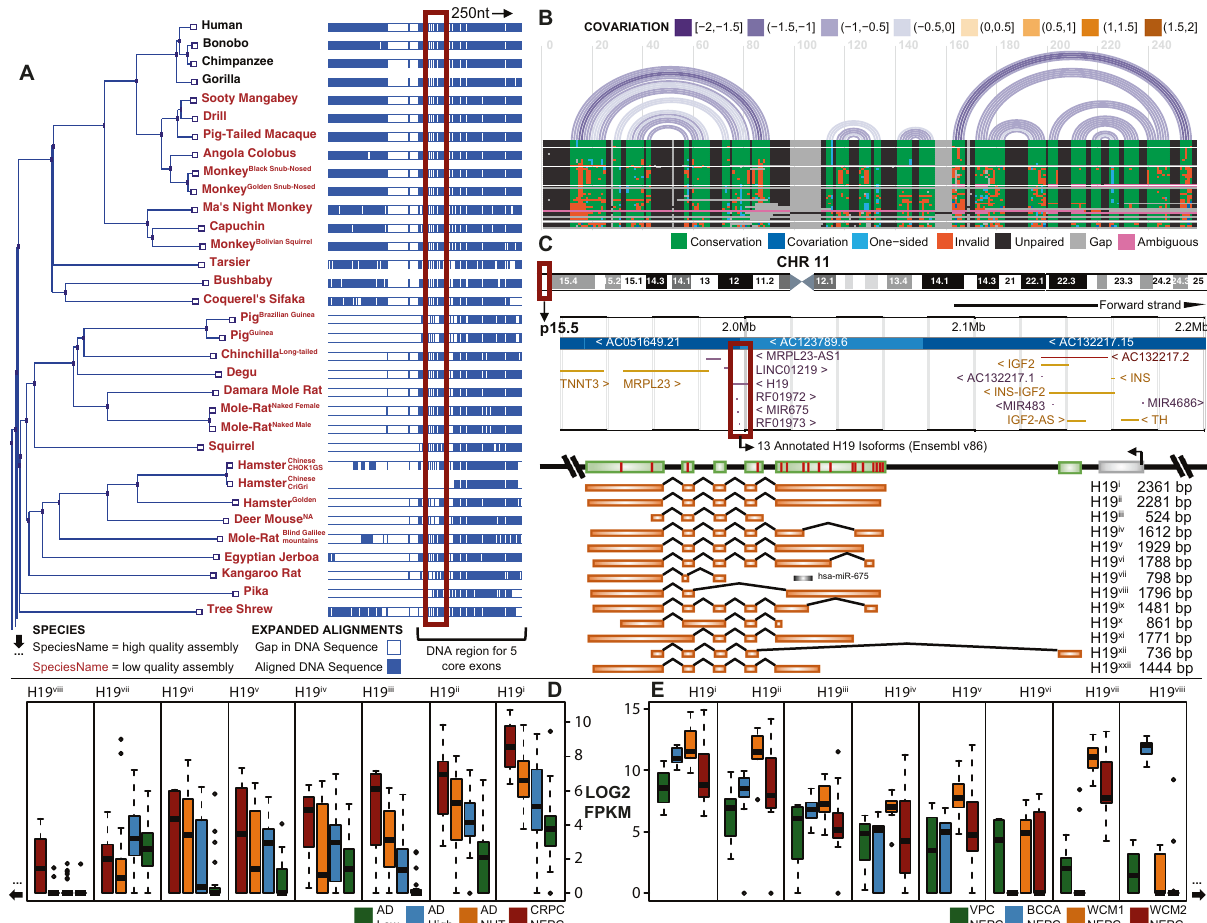
Fig. 2 H19 Isoform identi fi cation and conservation. A Phylogenetic tree (left side) and multiple sequence alignment (right side) for all available H19 DNA sequences of eutherian species ( n = 47) in Ensembl v93. Regions of the MSA that represent gap sequence(s) (white — unaligned sequences) are mostly intronic and regions representing complementary sequence(s) (blue — aligned sequences) are mostly exonic. The fi ve core exons of H19 (right side of MSA) are predominately conserved across all test species, suggesting shared functional importance. Due to limited fi gure space, only 33 of 47 species of this phylogenetic tree have been shown here. The complete ( n = 47) phylogenetic tree is shown in Supplementary Fig. 5. The highlighted box (red) spans a ~250 nt region where we narrow/zoom into for a B detailed MSA (horizontal bars) and integrate RNA secondary structure (purple arcs). Each bar/row represents a test species and is in the order shown from the phylogenetic tree in ( A and Supplementary Fig. 5). Each arc represents a nucleotide base pairing and binding event. Most of this region is highly conserved (green), yet despite areas with sequence differences (blue, light blue, orange, or gray), these changes do not affect H19 ’ s secondary structure, which is stable and contains little covariation (denoted by arc colour). C Schematic of human chromosome 11 (top), H19 ’ s locus and neighboring genes (middle), and Ensembls ’ 13 annotated isoforms and exon-exon structures (bottom) — H19i through H19xxii. The order and number of isoforms were assigned based on expression ranking observed in panels ( D ) and ( E ). Each isoform (orange) is transcribed from the DNA region (green) through alternative splicing events (red bars). Each red box in this panel highlights the region expanded below them. D Expression of each isoform in various clinical subgroups of the VPC cohort ( n = 75). H19i (rightmost boxplot) displays the highest expression across all subgroups, H19ii second, and so forth going left. The order of isoforms in this plot was determined by decreasing mean (m) expression across subgroups. E Expression of each H19 isoform in order (left to right) from panel D for NEPC samples only in VPC, BCCA, WCM1, and WCM2 cohorts ( n = 40). Due to limited space, only 8 of 13 isoforms were shown in panels ( D ) and ( E ). Box and Whisker plots display lower quartile, upper quartile, and median bounds of cohort expression at the box ’ s minima, maxima, and centerlines, respectively. Whisker lines display lower (bottom) and upper (top) extreme value ranges. Single data points represent outliers in a cohort. The complete set of H19 isoform expression plots ranked by decreasing m is shown in Supplementary Fig. normal imprinting range of 40 – 60% (Fig. 3C). Similar results xenograft model (Supplementary Fig. 11B). These results suggest that the elevated level of H19 seen in NEPC could be secondary to changes in methylation of the imprinting center (ICR1) compared to AdPC.